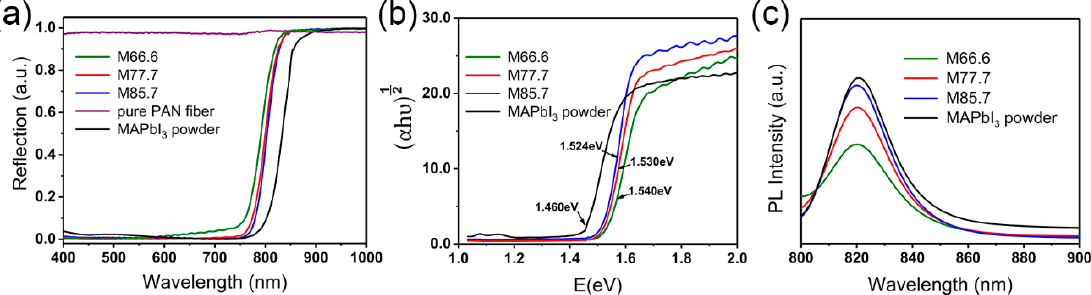
Figure 5. Optical properties of the composite fibers, MAPbI 3 powder, and pure PAN fibers. ( a ) UV-Vis-NIR diffused reflectance spectrum (DRS), ( b ) bandgap, and ( c ) photoluminescence spectra.